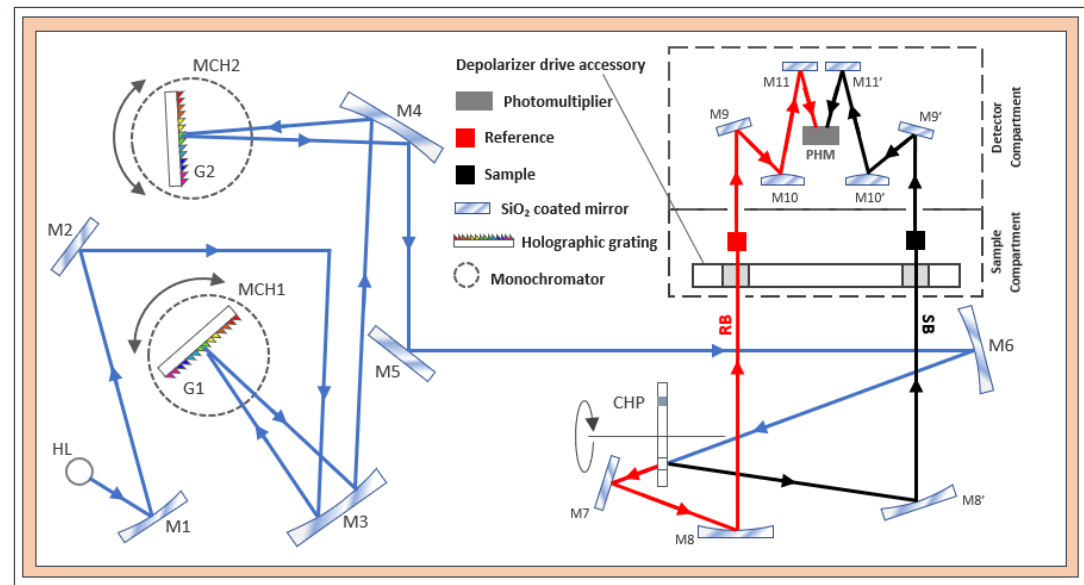
Figure 4. Schematic representation of Lambda 950 transmission spectrophotometer setup redrawn and adapted from reference [46].